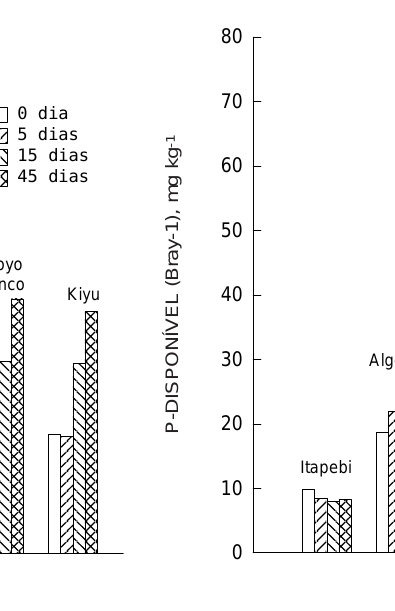
Figura 2. Teores de fósforo disponível por Bray-1 nos seis solos, nas amostras originais e após serem submetidas aos períodos de alagamen- to.